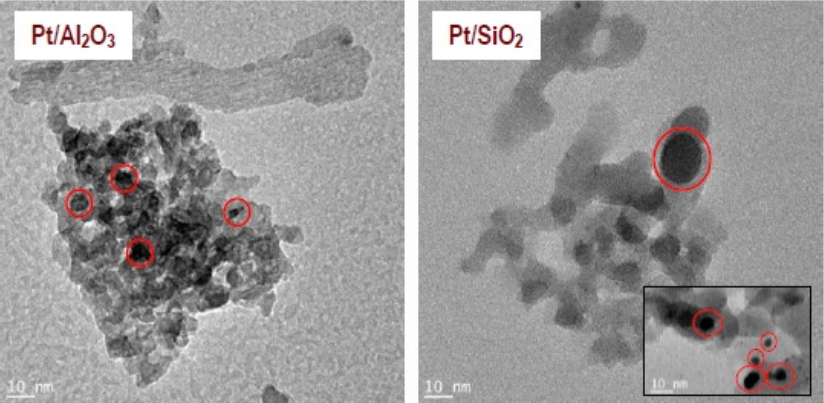
Figure 2. TEM images of fresh Pt catalysts supported on Pt/Al or Pt/ZrO -SiO ; a few representative Pt particles are marked with circles in the 2 2